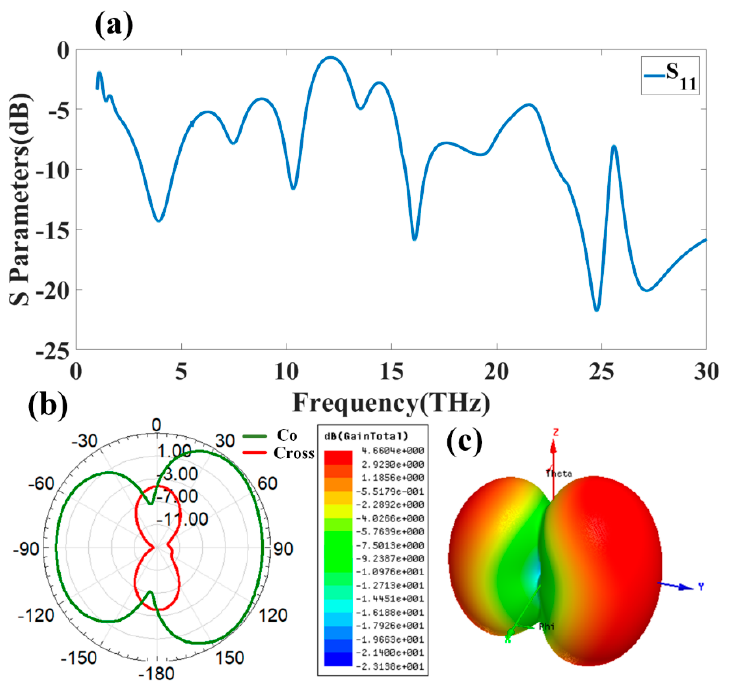
Figure A3. ( a ) Calculated S-parameters for the type-4 antenna. Calculated directivity in ( b ) 2D (with co- and cross-polarization) and ( c ) 3D, by considering single-port (Port-1) excitation.